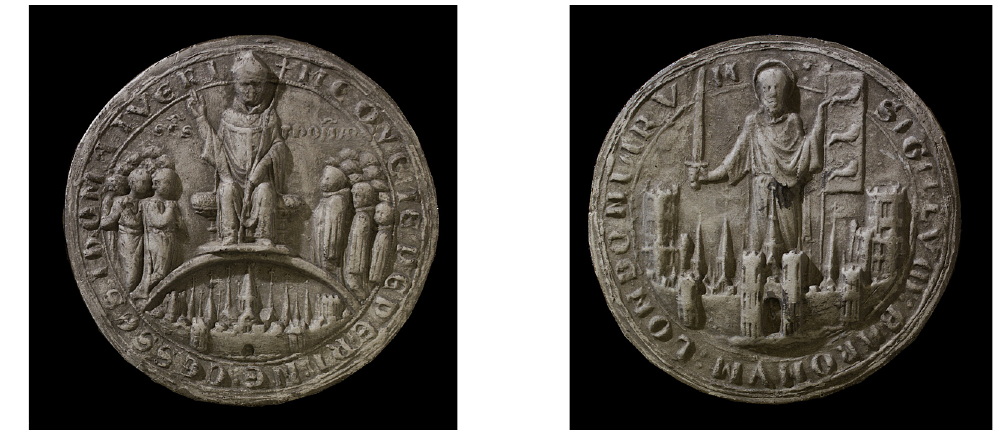
Fig. 5. Seal of the Barons of London, reverse (St Thomas Becket) and obverse (St Paul), c. 1220. Society of Antiquaries of London. LDSAL2022.D8.14.1-2. © The Society of Antiquaries of